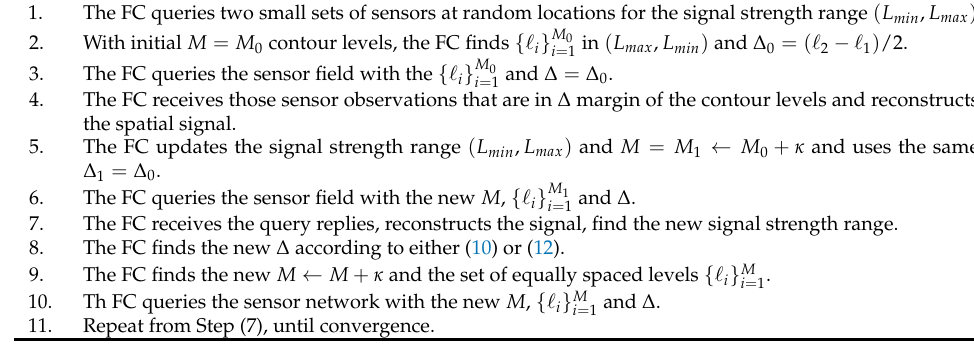
Table 2. Summary of the proposed